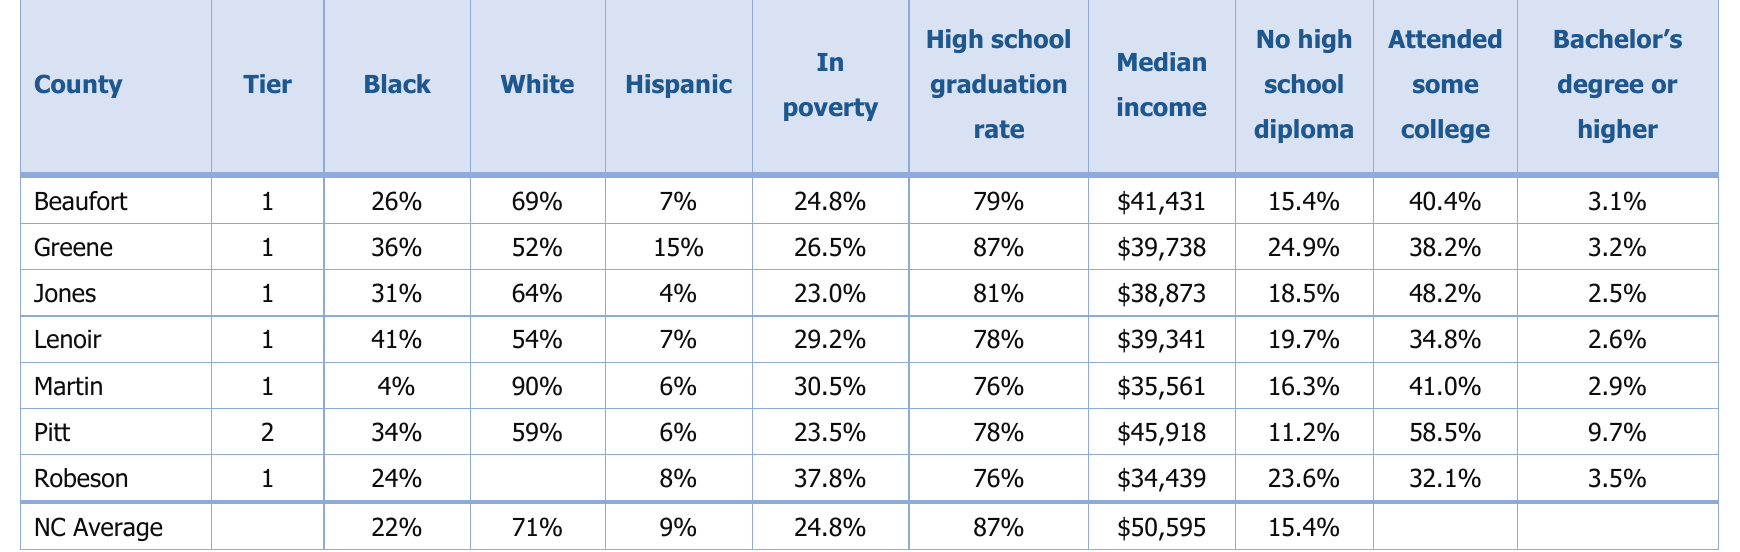
Table 2. 2010 Participating County